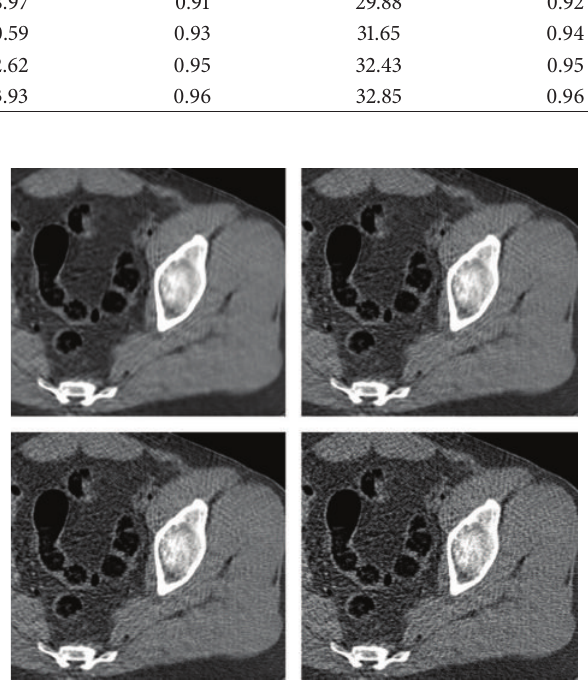
Figure 18: Error maps for the lesion detectability test, built with respect to the reference image. Upper to lower rows, left to right: our method, PWLS, ATM, and FBP images. Darker shade corresponds to higher error. The lesion is not observed in any version, which means it is recovered correctly by all the methods; however, in FBP image the lesion is obscured by streaks.